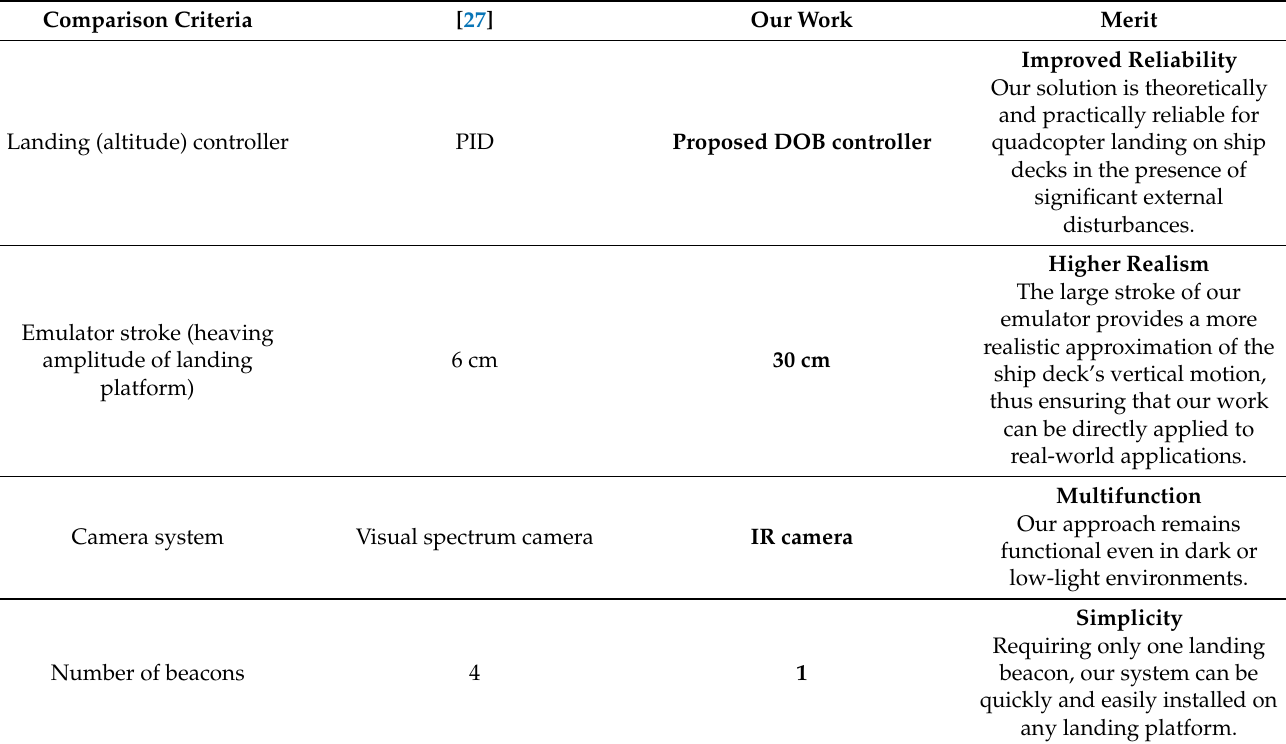
Table 1. Comparing our proposed work and the most related work in the literature [27]. Comparison Criteria [27] Our Work Merit Improved